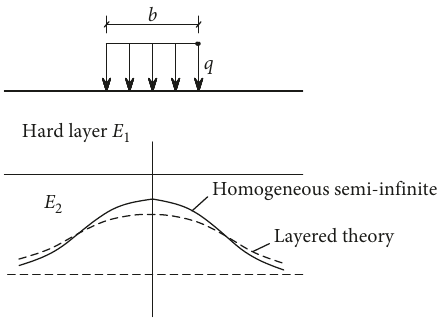
Figure 8: Stress diffusion when E